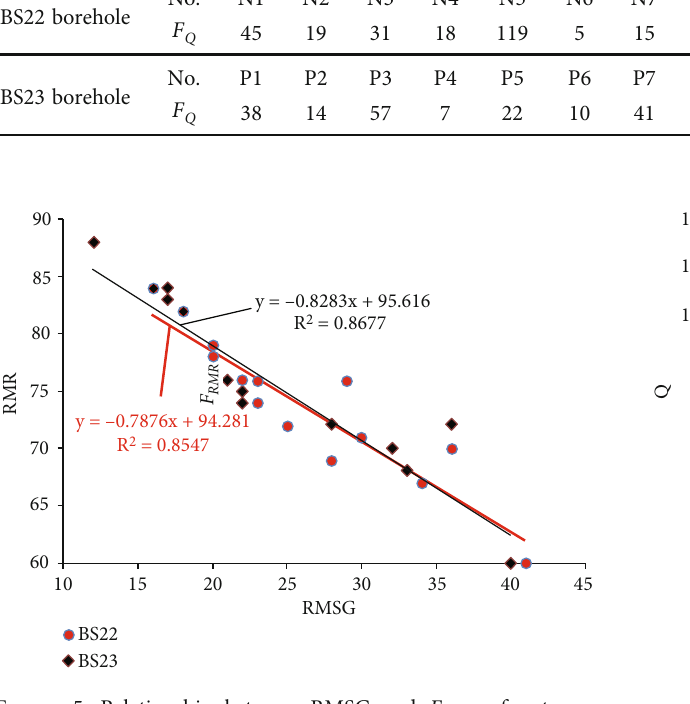
Figure 6: Relationship between RMSG and F RMR of outcrops around BS22 and BS23 boreholes.